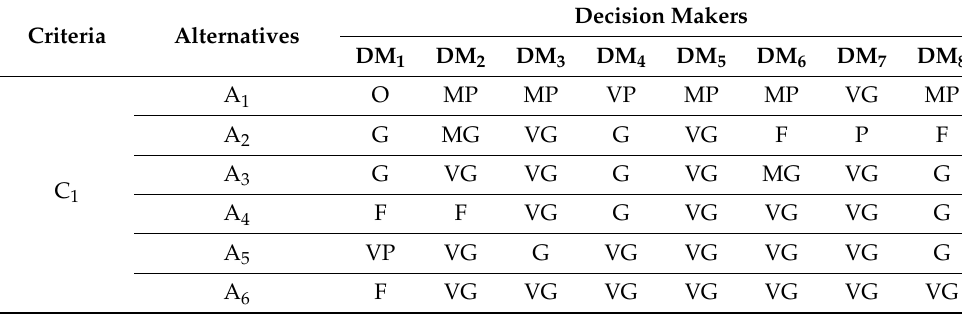
Table 5. Evaluation of leader alternatives by decision makers.